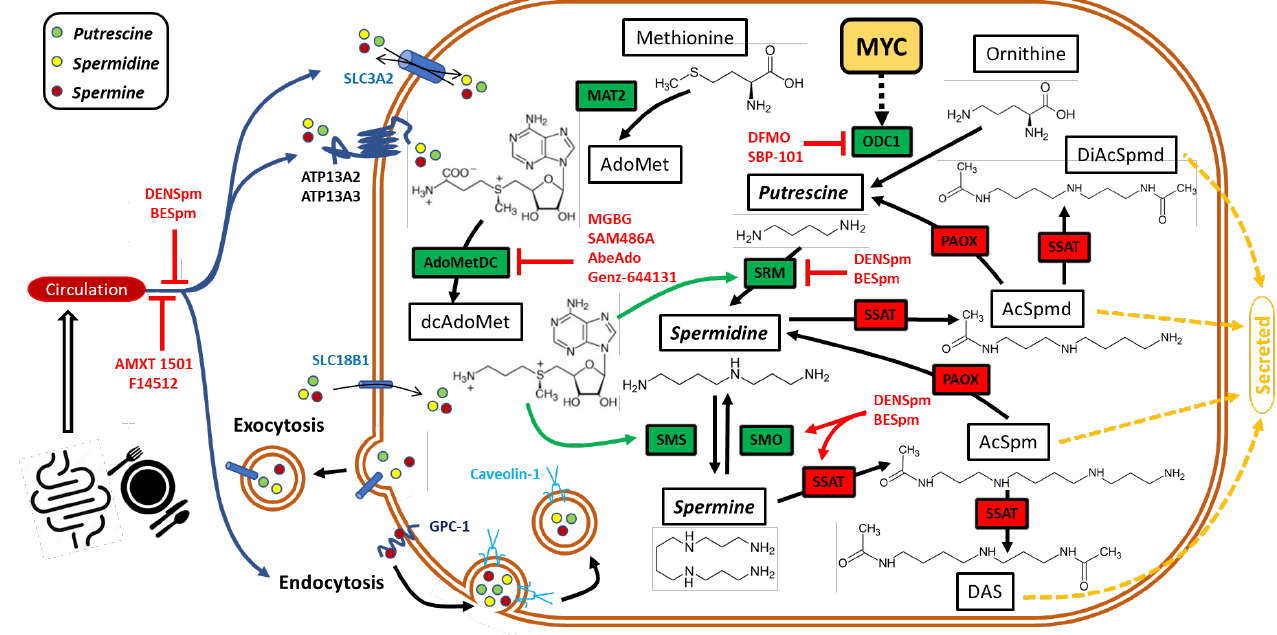
Figure 1. Biosynthesis, metabolism, transport, and targeting of polyamines. (1) Polyamine biosynthesis: ornithine is generated from arginine and converted into putrescine by ornithine decarboxylase (ODC1). Spermidine synthase (SRM) turns putrescine into spermidine, which is further converted into spermine by spermine synthase (SMS). Synthesis of spermidine and spermine requires aminopropyl moiety from decarboxylated S-adenosylmethionine (dcAdoMet), which is converted from S-adenosylmethionine (AdoMet) by S-adenosylmethionine decarboxylase (AdoMetDC). AdoMet is produced from methionine by methionine adenosine transferase (MAT). (2) Polyamine catabolism: spermidine and spermine are decomposed by spermidine/spermine-N1-acetyltransferase (SSAT) into N-acetylspermidine (AcSpmd) and N-acetylspermine (AcSpm), respectively. AcSpmd and Ac- Spm are further catabolized by acetylpolymine oxidase (PAOX) into spermidine and putrescine, respectively. In addition, spermine oxidase (SMOX) specifically degrades spermine into spermidine. (3) Polyamine transport: exogenous sources of polyamines, including foods and gut microbiota. Uptake of polyamines from the gut may be mediated by caveoline-1- and NOS-2-dependent pro- cesses. Solute carrier transporter SLC3A2 imports putrescine. At the cellular level, heparan sulfate proteoglycans glypican-1 (GPC-1) sequesters spermine for its uptake, likely through endocytosis. Caveoline-1-dependent endocytosis mediated polyamine uptake from extracellular